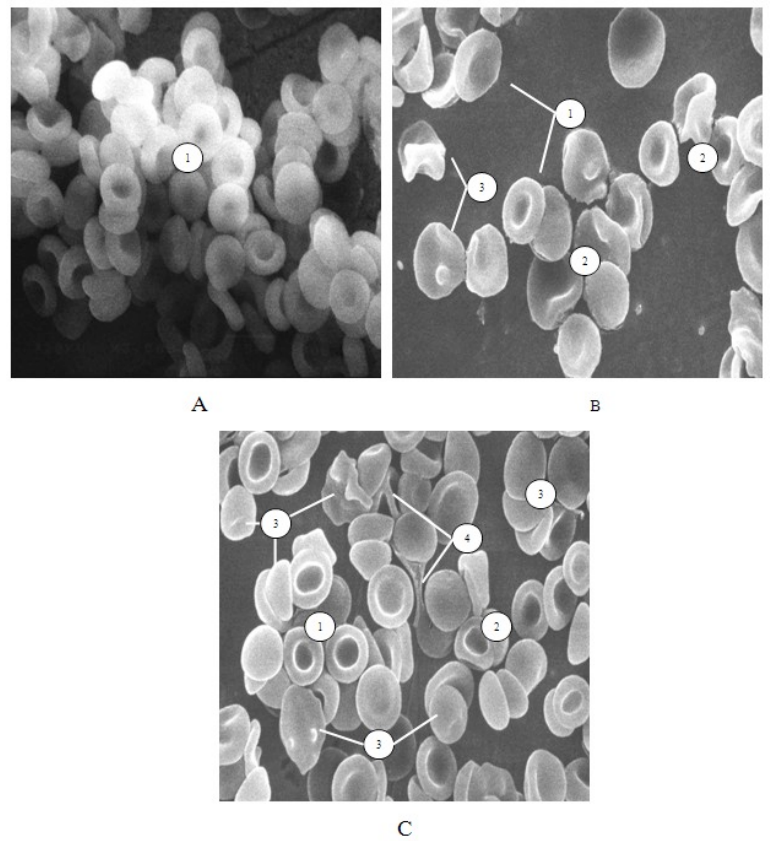
Fig. 1. Restructuring of erythrocytes of peripheral blood of female volleyball players with eukinetic, hypodynamic and hyperkinetic types of hemo-dynamic after the physical activity of the maximum aerobic power: 1 – normal forms of erythrocytes, 2 – reversibly changed forms of erythrocytes, 3 – irreversibly changed forms of erythrocytes, 4 – “adhesion threads”. The scanning electronic microscopy. Fig. 1A is increased in 1200 times; fig. 1B and fig. 1C are increased in 1500